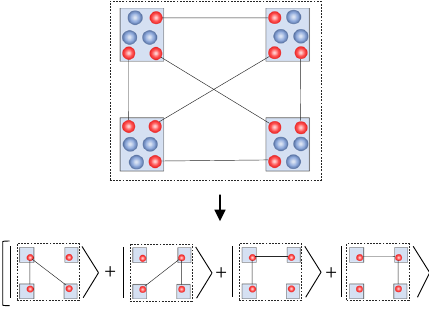
Fig. 5 Example. Schematic example of the initial state (upper fi gure) of Eq. (34) and fi nal desired superposition (bottom fi gure) of Eq. (41). Red vertices represent the resource qubits and blue vertices represent the auxiliary qubits, which are omitted in the bottom picture for illustrative